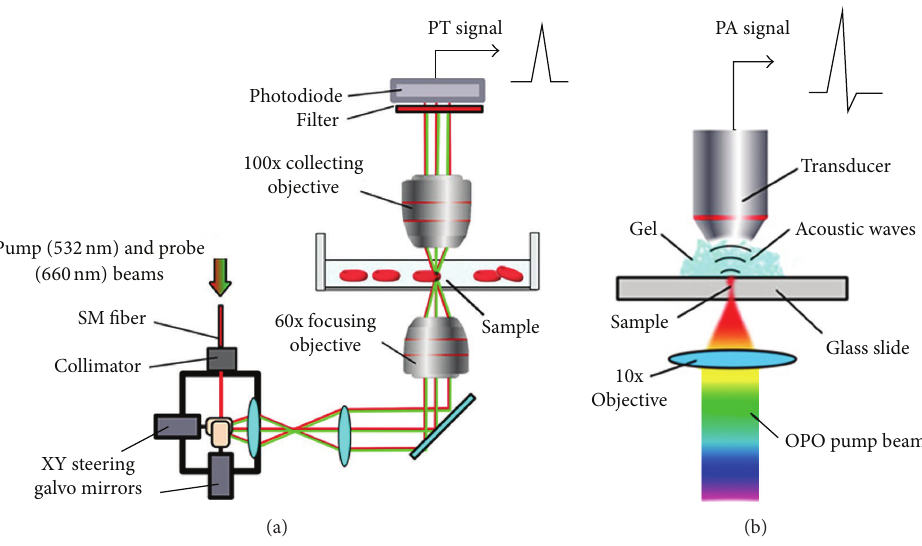
Figure 2: Schematics of PT and PA instrumentation. (a) Laser scanning confocal two-beam (pump-probe) PT microscopy (PTM). (b) PA spectrometer with an automatic spectrally tunable